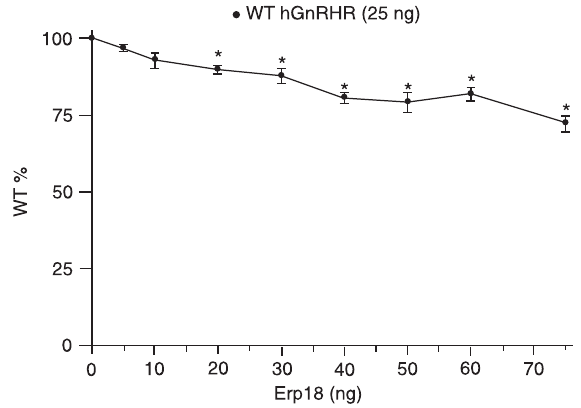
Figure 1. Wild type percent (WT%) indicates the inositol phos- phate production upon buserelin stimulation of WT human go- nadotropin-releasing hormone receptor (hGnRHR) co-trans- fected with the ERp18 chaperone. Data are reported as mean ± SEM of at least three independent experiments in triplicate incu- bations. *P < 0.05 compared with WT hGnRHR (25 ng) without ERp18 co-transfected (one-way ANOVA followed by the Bonfer- roni